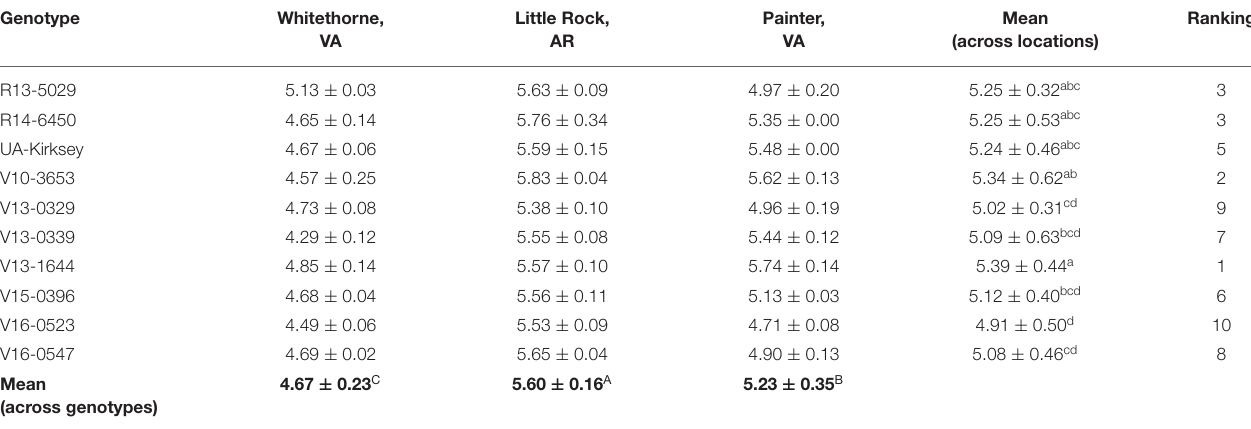
TABLE 10 | Ash contents (%, d.b.) of 10 = edamame genotypes planted in different locations. Genotype